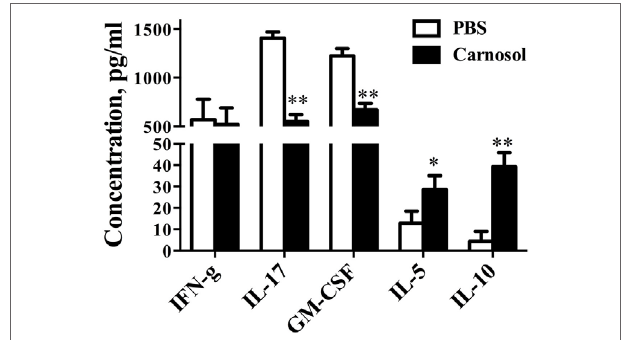
FigUre 3 | Carnosol treatment decreased inflammation and cytokine production. Mice were treated with PBS or carnosol at the day of experimental autoimmune encephalomyelitis induction and sacrificed at day 30 p.i. as described in Figure 1a . Splenocytes were harvested and stimulated with 25 µg/ml MOG 35–55 for 3 days. Cytokine concentrations in culture supernatants were measured by ELISA. n = 5. Symbols represent mean ± SD ( n = 5 each group). * p < 0.05 and ** p < 0.01. Nonparametric test. One representative of three independent experiments is